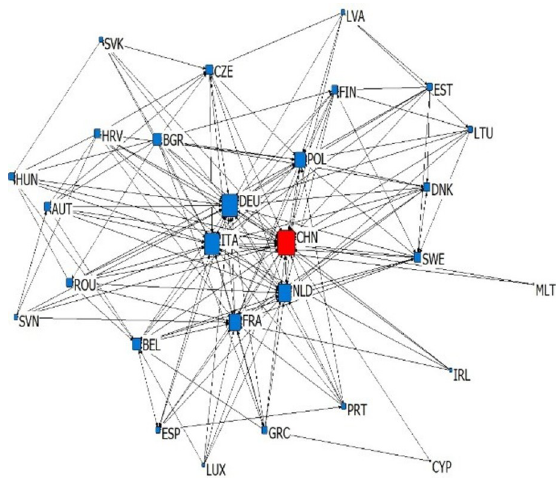
Fig 4. Upper vertical intra industry import dependence